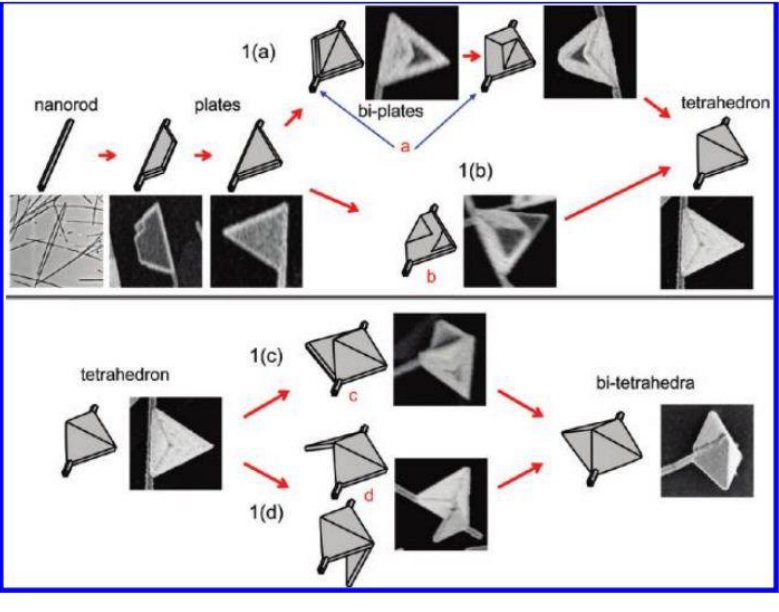
Figure 4. Growth mechanisms of silver nanoflags from silver nanorods in DMF (reprinted with permission from [43]. Copyright (2010) American Chemical